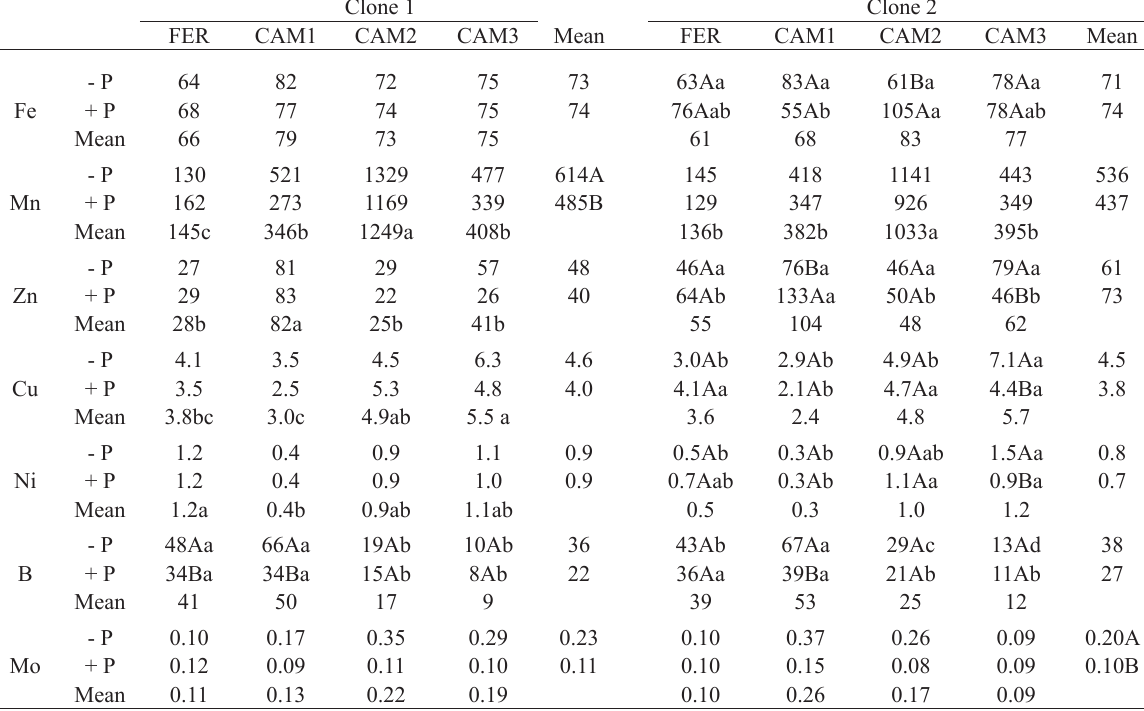
The Fe, Mn, Zn, Cu, Ni, B and Mo contents (mg kg -1 ) in leaves of yerba mate clones in response to P fertilization, at 210 days after installation of the experiments 1